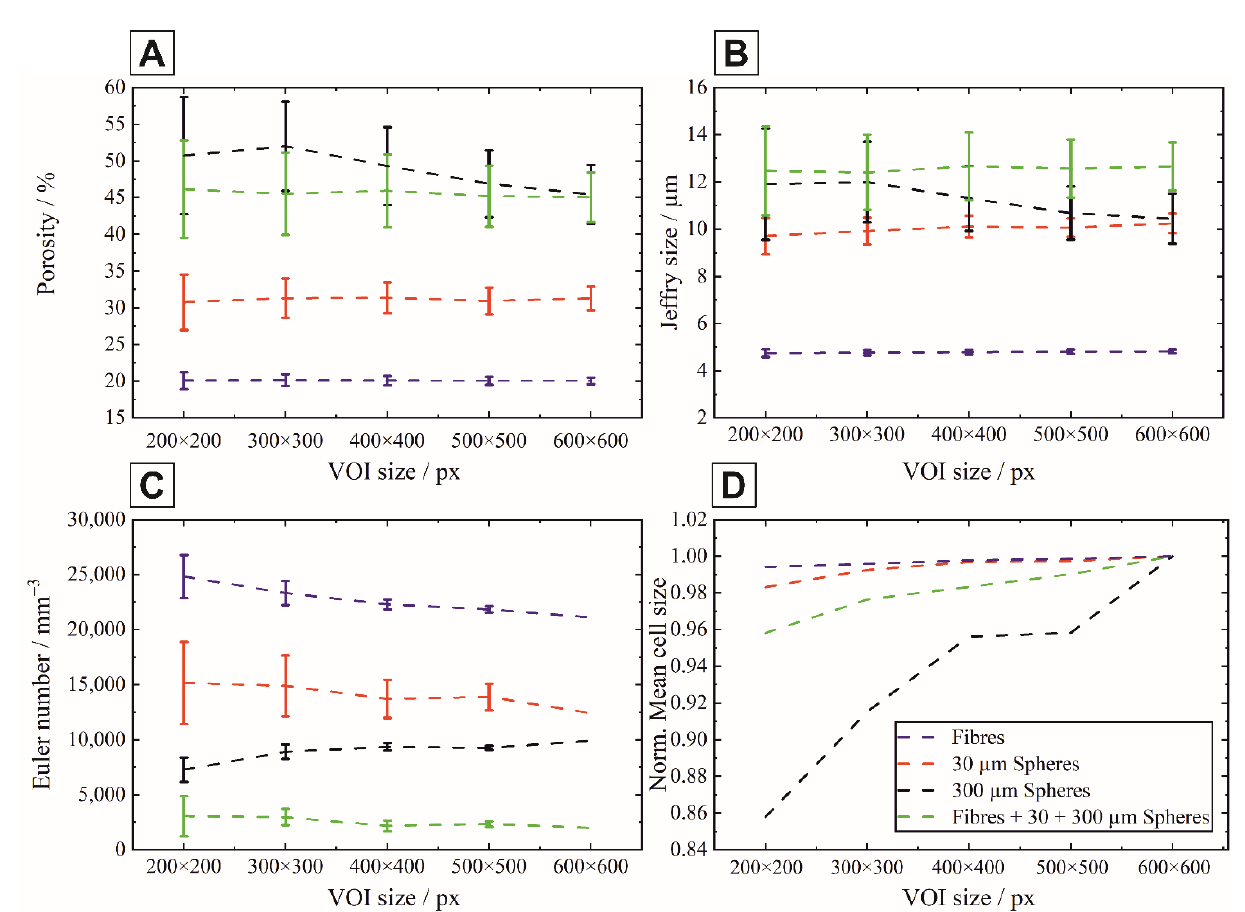
Figure 5. Evaluation of the Minkowski functionals and mean cell size for determination of the representative Volume-of- Interest (VOI). Porosity ( A ), Jeffry size ( B ), Euler number ( C ) and Normalized Mean cell size ( D ) in dependence of the examined VOI between 200 × 200 and 600 × 600